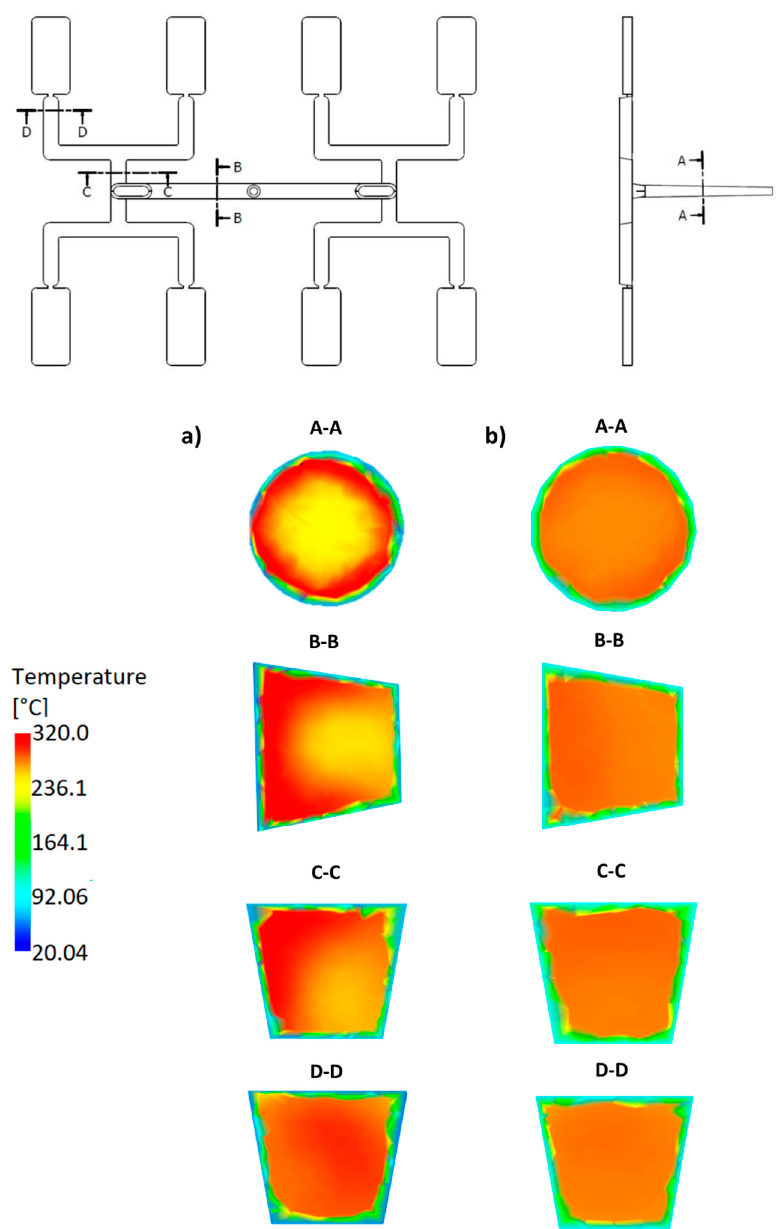
Figure 22. Temperature distribution in the selected cross-sections of the runners for different relaxation time at high injection rate in the case of the geometry with one overturn element G1 : ( a ) λ = 0.001 s ( I m = − 35%), ( b ) λ = 0.1 s ( I m = − 1%).